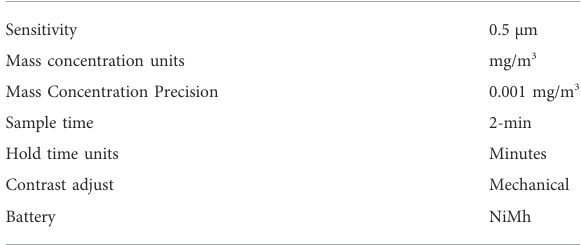
TABLE 5 Detailed speci fi cation of the sound pressure level